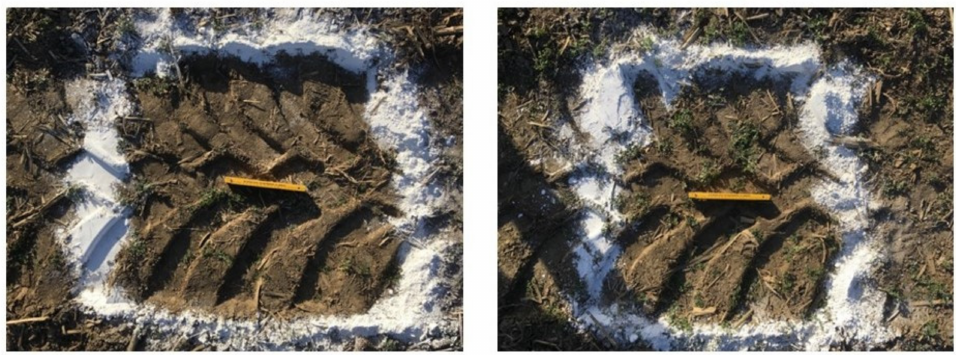
Figure 1. Tire print of a rear slurry tanker wheel at the half-filled tanker filling level with low tire inflation pressure ( left ) and high tire inflation pressure ( right